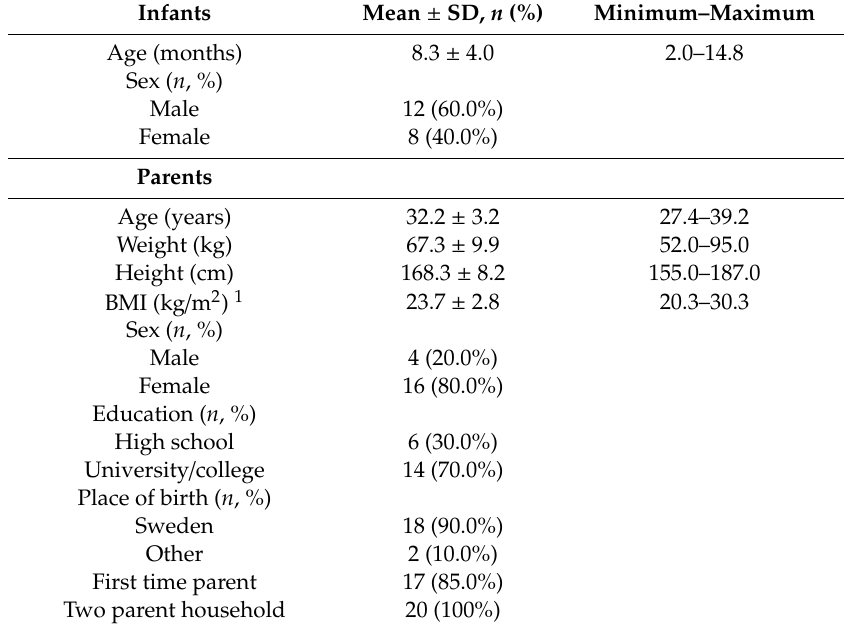
Table 1. Descriptive characteristics of the participating parents and infants ( n = 20).